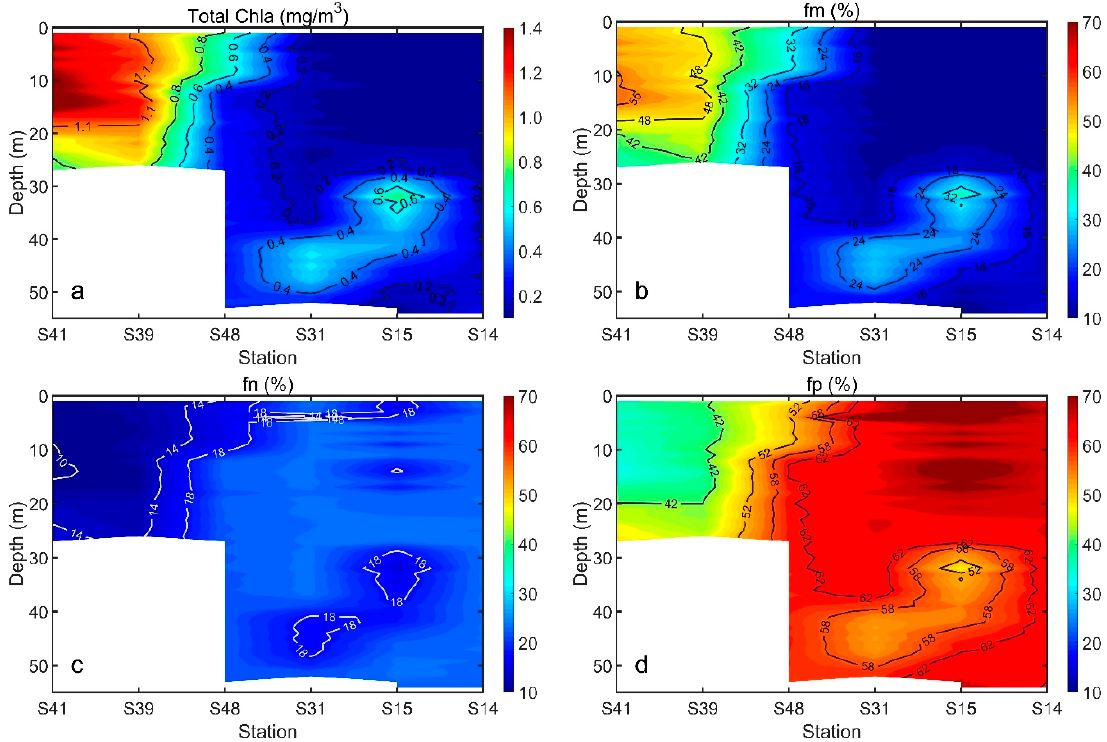
Figure 9. Vertical distribution along transect-A of the concentrations of total chlorophyll ( a ), and the proportions of micro- ( b ), nano- ( c ), and pico-phytoplankton ( d ), respectively.